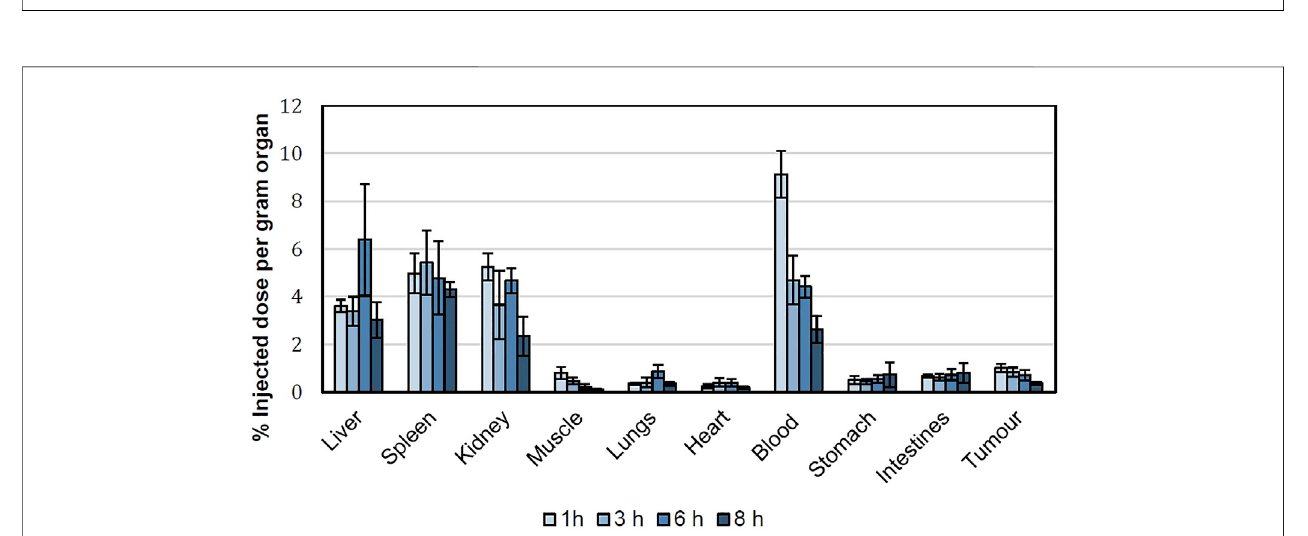
FIGURE 4 | Scintigraphic images acquired from a female nude BALB/c mice at 1, 3, 6 and 8 h post-injection with 200 µCi 99mTc-labeled niosomes.